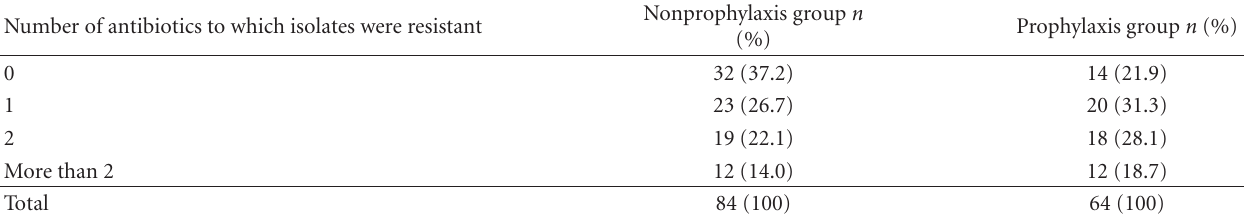
Table 3: The frequency distribution of coresistance in the nonprophylaxis and the prophylaxis groups. Nonprophylaxis group n Number of antibiotics to which isolates were resistant